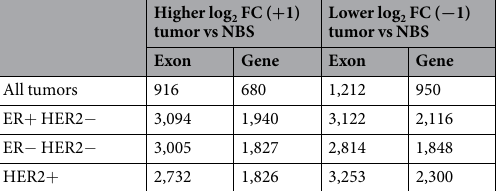
Table 1. Number of exons and genes found to have differential exon usage among the three clinical subtypes compared to